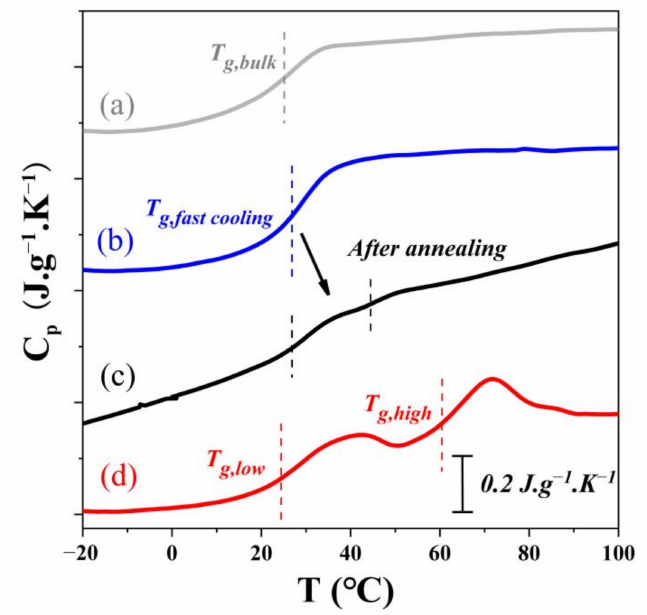
Figure 6. The DSC curves for the PBMA@AAO after different thermal treatments. ( a ) The DSC curve of bulk PBMA; the DSC curves of the PBMA@AAO ( b ) after fast cooling; ( c ) after annealing; ( d ) after slow